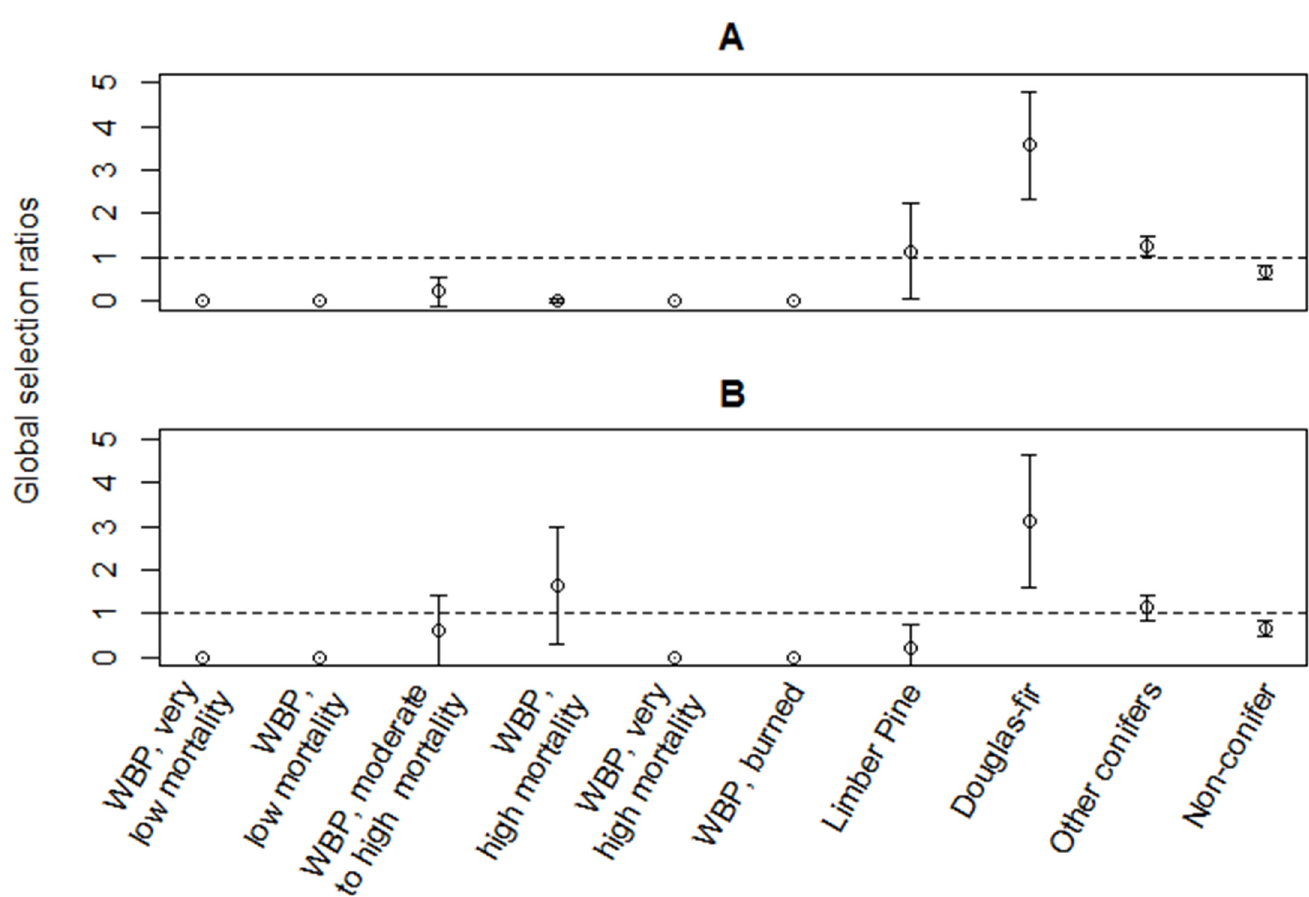
Fig 3. Home range habitat selection. Clark ’ s nutcracker selection of the home range habitat as compared to habitat available within 32 km in ( A ) 2011 (all nonbreeding birds) and ( B ) 2012 (breeding birds only). The Manly selectivity measure ( ± Bonferroni 95% confidence intervals (CI ’ s)) was used to determine if habitats were used in higher proportion than the proportion available ( > 1), used in the same proportion as the proportion available (CI ’ s include 1), used in lower proportion than the proportion available (0 < X < 1) or never used (0). Whitebark pine is abbreviated as WBP.